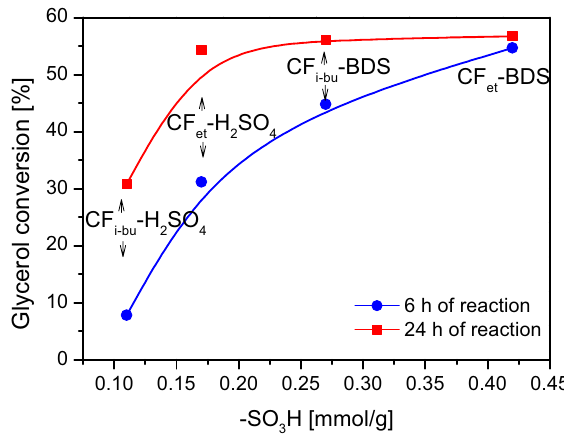
Figure 10. Glycerol conversions versus the concentration of sulfonic groups on CFs for the glycerol etherification with